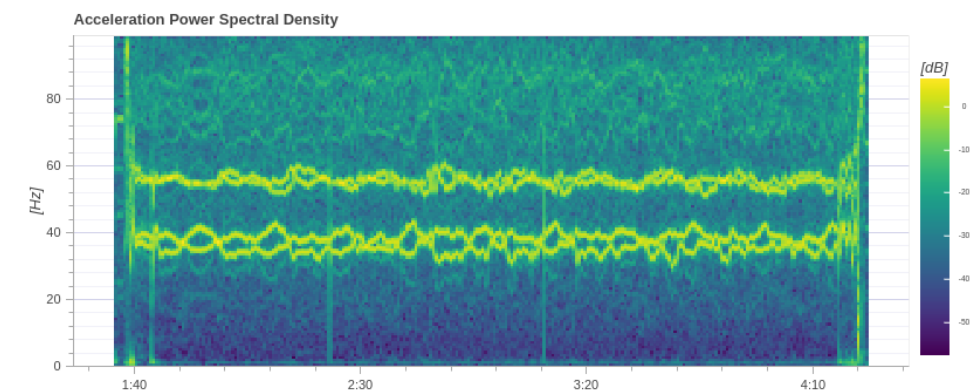
Figure 10. Spectrum for a rigid-frame drone QAV-R 5 (cid:48)(cid:48) Racer collected via PX4 log collector and plotted using PX4 Flight